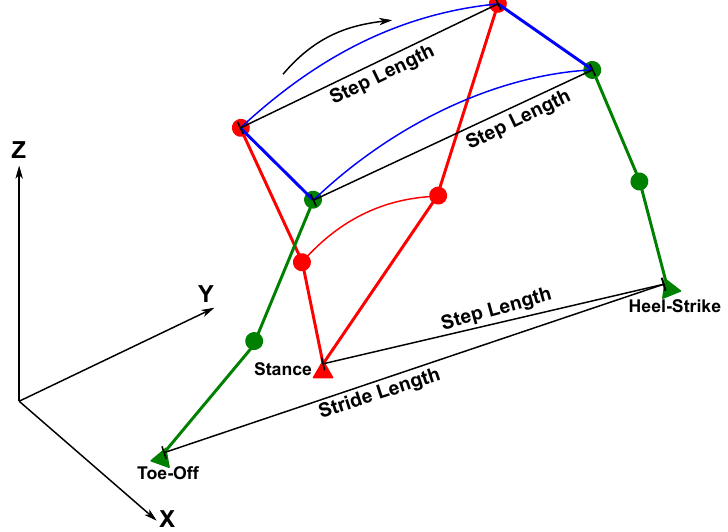
Figure 6. Step and stride lengths extracted from a solution set of forward kinematics. In this case, the left foot is in stance phase while the right foot is in the swing